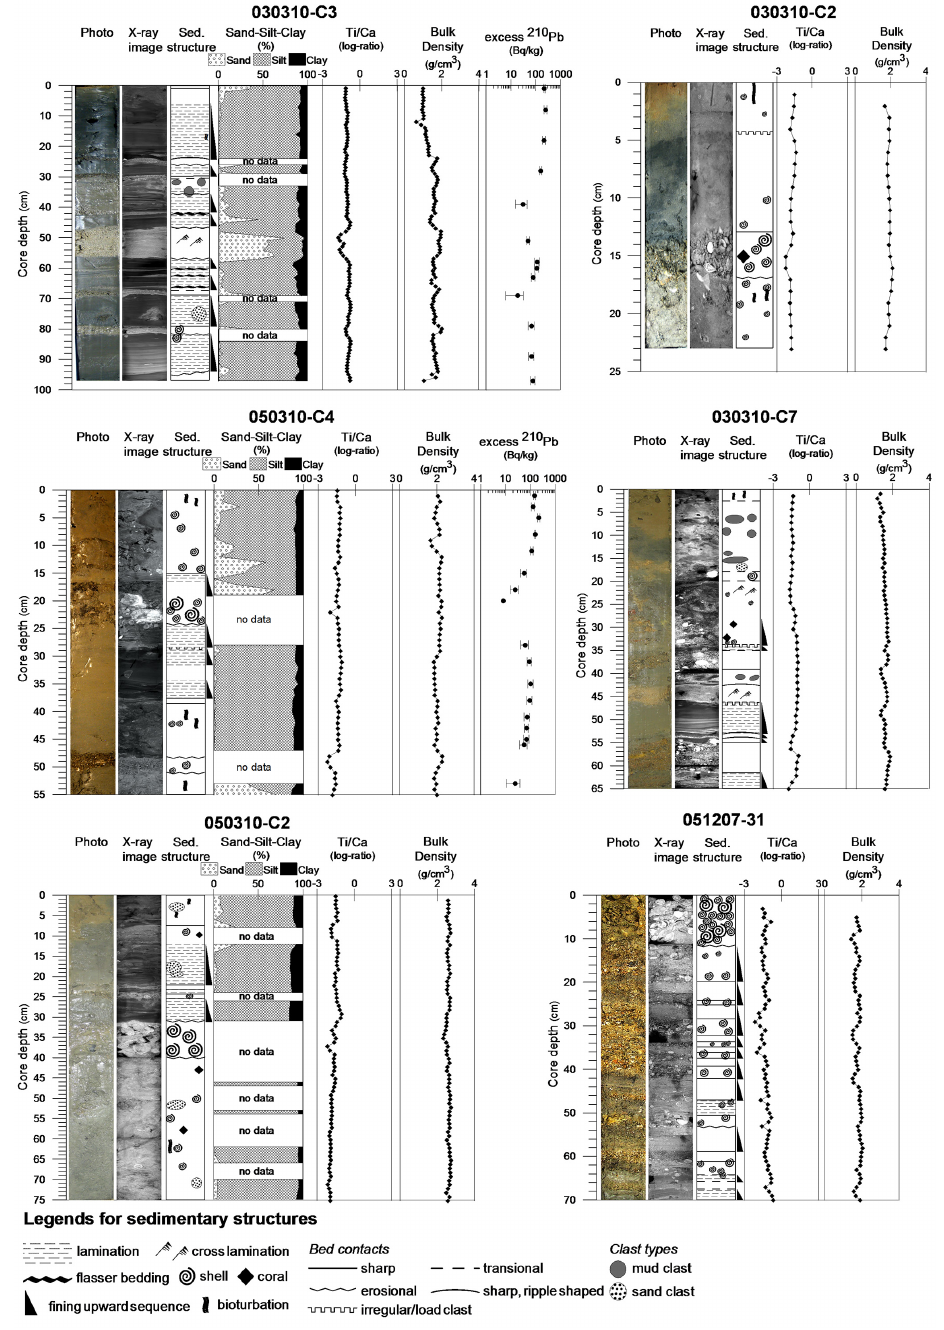
Figure 2. Interpretation of the sediment